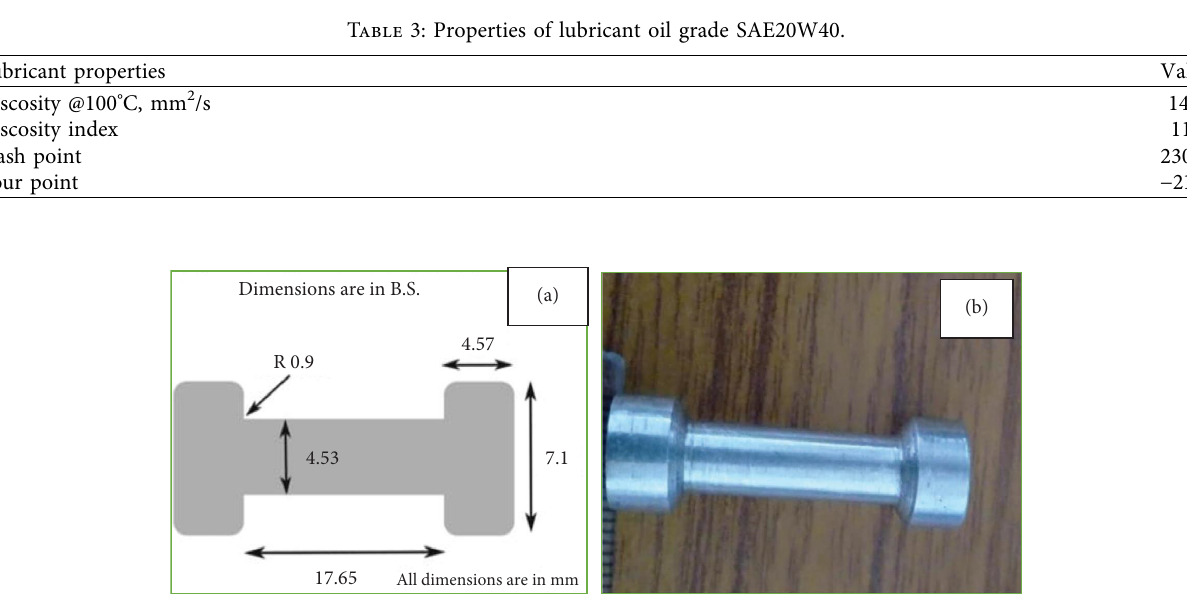
Figure 4: (a) Dimensions (b) specimen for test. Table 4: Elemental composition of